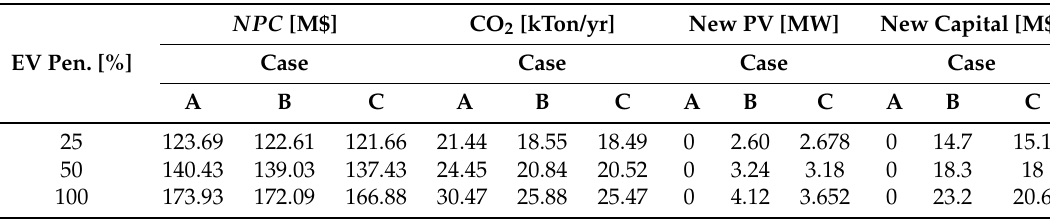
Table 3. System costs and emissions at 1.67 $/L